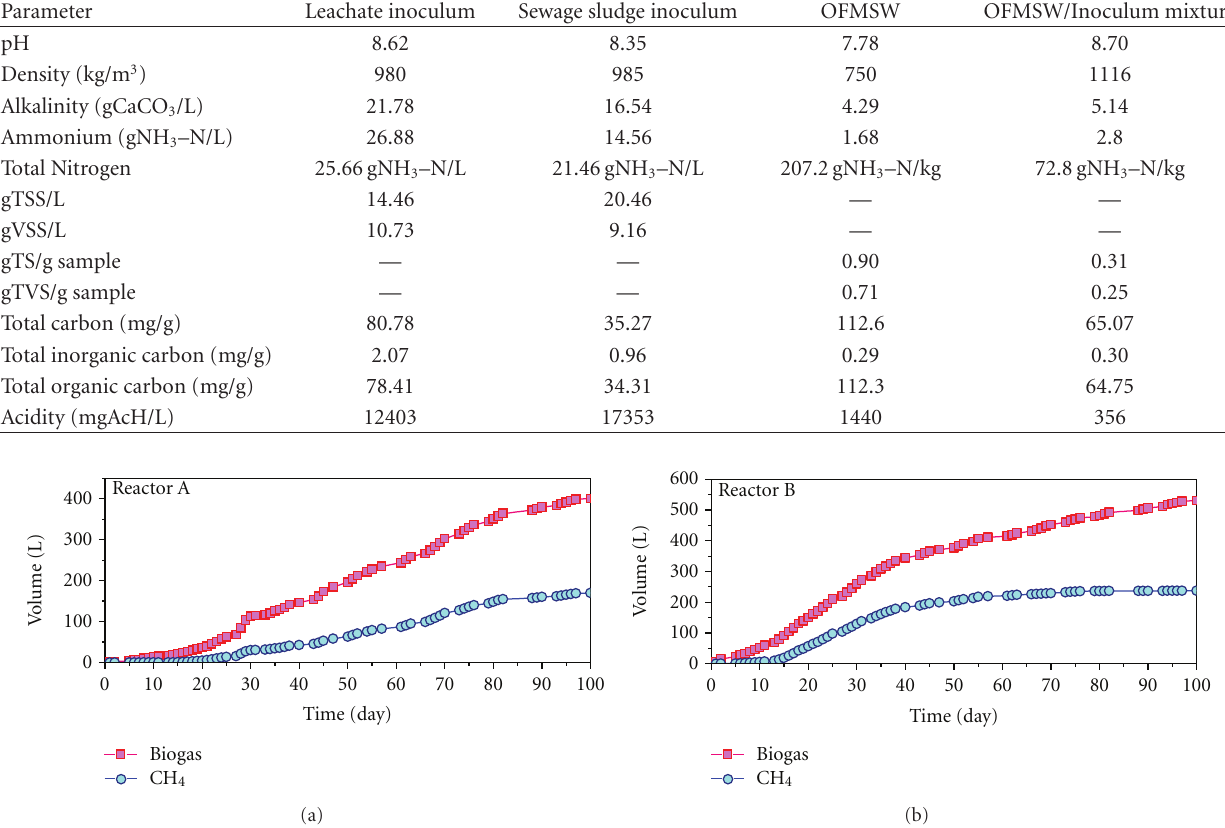
Figure 2: Accumulation of biogas and methane productions in the modified SEBAC